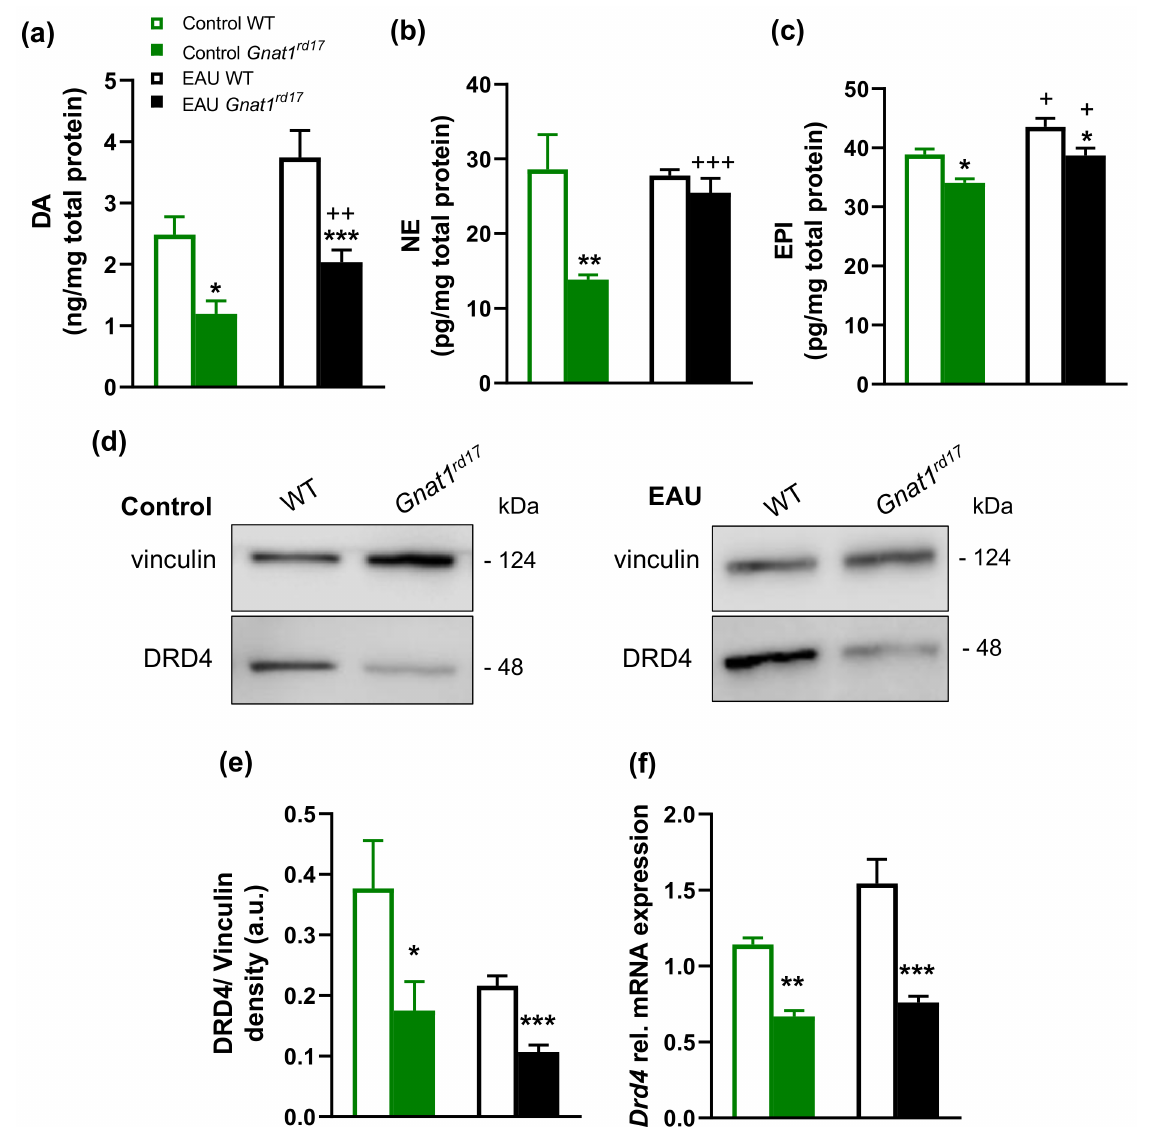
Figure 5. Alterations of the retinal catecholaminergic system in Gnat1 rd17 mice. ( a ) DA, ( b ) NE, and ( c ) EPI levels in the neuroretina of control (green bars) and EAU (black bars) mice (day 14 after immunization), both WT (open bars) and Gnat1 rd17 (filled bars). The data are presented as the mean ± SEM of 10 neuroretinas from 5 mice per group and were analyzed by one-way ANOVA followed by the Tukey–Kramer multiple comparison test. * p < 0.05, ** p < 0.01, and *** p < 0.001: significant differences between WT and Gnat1 rd17 mice; + p < 0.05, ++ p < 0.01, and +++ p < 0.001: significant differences between control and EAU groups within WT and Gnat1 rd17 mice. The experiment was repeated twice with similar results. ( d ) Representative Western blot images and ( e ) densitometric analysis of DRD4 relative protein expression. Vinculin was used as a protein-loading control. The data represent the mean ± SEM of 5 to 6 neuroretinas from 5 to 6 control (green bars) and EAU (black bars) mice on day 14 after immunization, both WT (open bars) and Gnat1 rd17 (filled bars). The data shown are representative of three independent experiments. Differences between WT and Gnat1 rd17 groups: * p < 0.05 and *** p < 0.001 (unpaired t -test). ( f ) qRT-PCR results of mRNA expression for DRD4 in the neuroretinas of control (green bars) and EAU (black bars) mice on day 14 after immunization, both WT (open bars) and Gnat1 rd17 (filled bars). The data are presented as the mean ± SEM (unpaired t -test; n = 10 neuroretinas from 5 mice per each group; ** p < 0.01 and *** p < 0.001: differences between WT and Gnat1 rd17